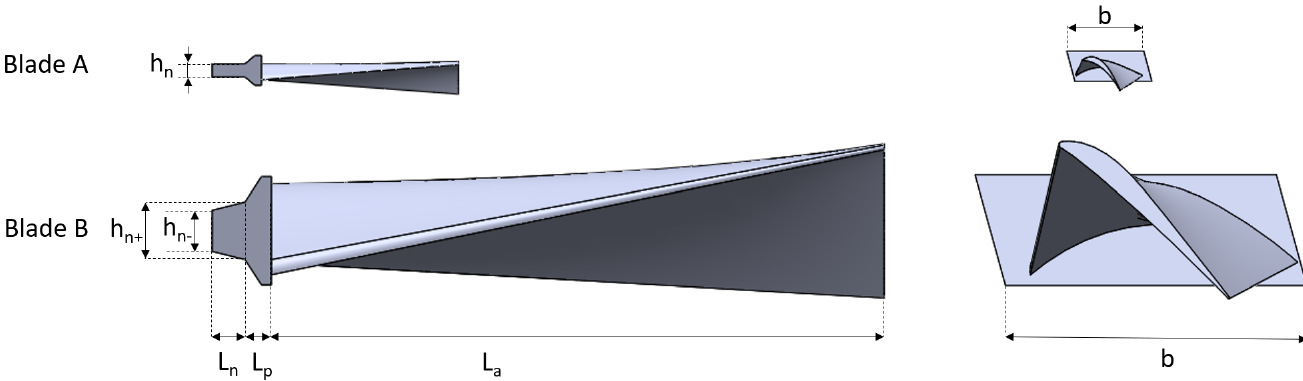
Figure 9. CAD model front and top view of the two blades investigated with this paper. The figure indicates proportions, and the values for symbols are shown in Table